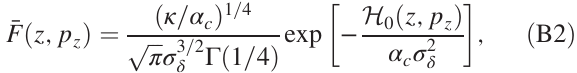
ffiffiffiffiffiffiffiffiffiffiffiffiffiffiffi